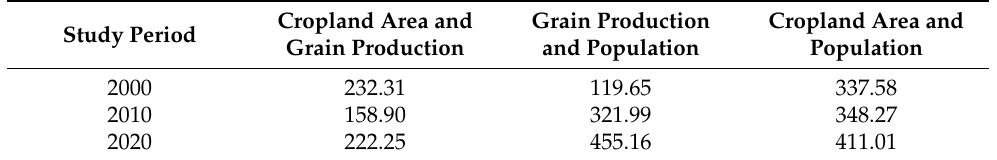
Table 3. Spatial overlap of barycenters.